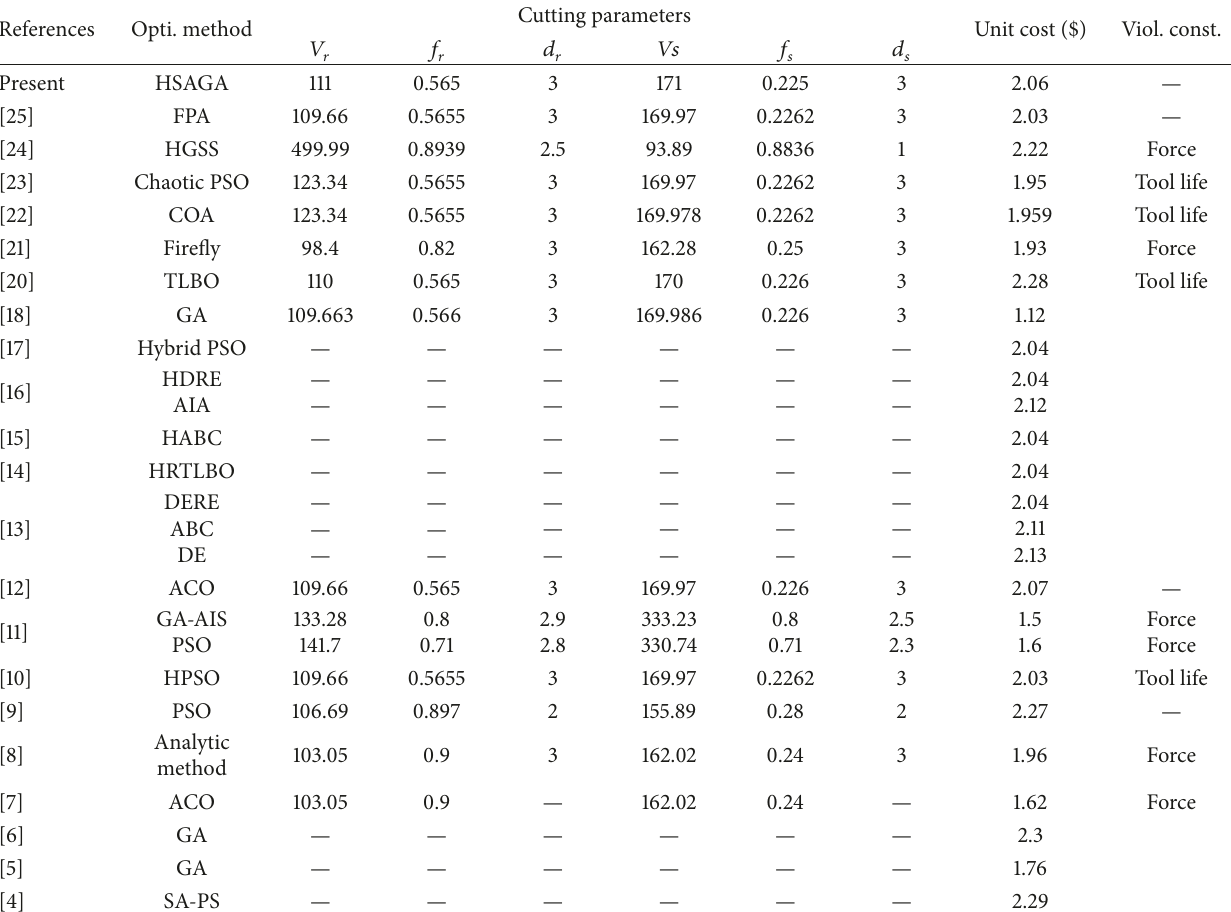
Table 6: Comparison of obtained results of various optimization